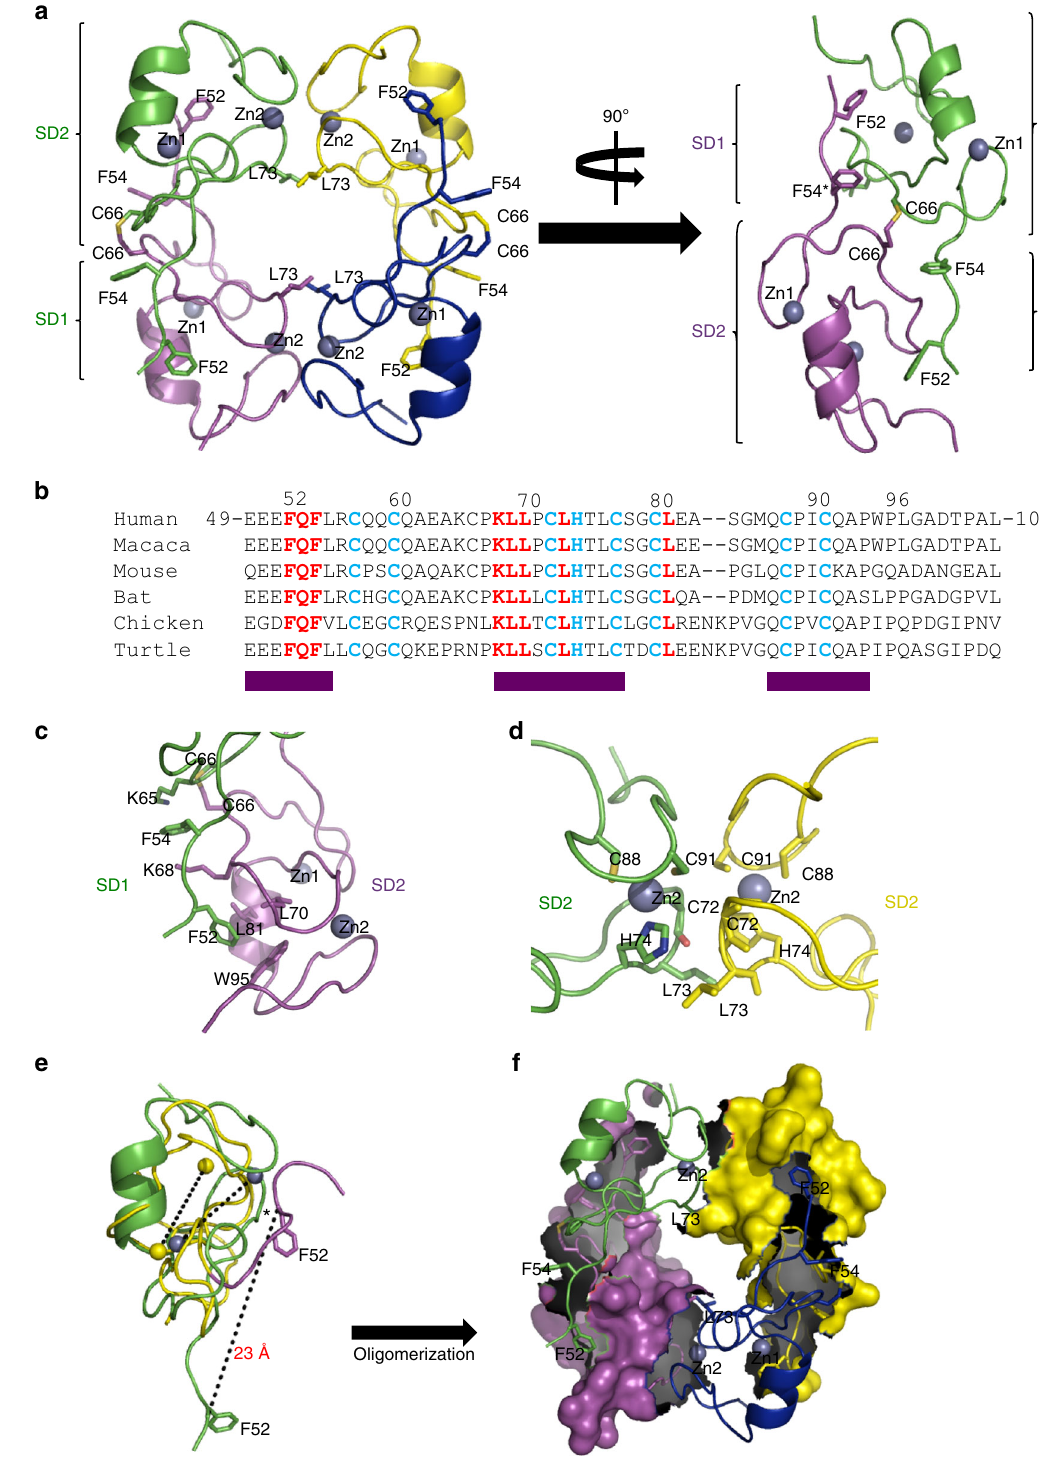
Fig. 1 Crystal structure of PML RING tetramer. a Crystal structure of PML RING tetramer. The residues 51 – 97 of crystallized PML RING49 – 104 are visible in the electron density map. Four PML monomers are colored in green, magenta, blue and yellow, respectively. The contact residues (F52, F54 and L73) are shown in stick representation. Zn ions are shown in sphere representation. Sub-domain 1 (SD1 FQF ) and sub-domain 2 (SD2) are bracketed. b Sequence alignment of the PML RING domains from different species. The conserved residues lying in the F52/54-interfaces and L73-interfaces are highlighted in red, while the conserved Zn-binding residues are colored in cyan. The deep purple boxes underneath the sequences are used to highlight the conserved (greater than 5 out of 6) residues among PML RING. c , d Enlarged views of PML RING dimeric interfaces. The residues involving PML oligomerization are shown in stick representation. e Structural superimposition between different PML RINGs. The NMR 16 and crystallographic PML RINGs are colored in yellow and green, respectively. L73 positions are labeled with “ Asterisk ” . The internal Zn – Zn distances and the putative F 52 Q 53 F 54 swing are highlighted with dash lines. f The buried areas of the SD1 FQF /SD2 and SD2/SD2 interfaces are shown in